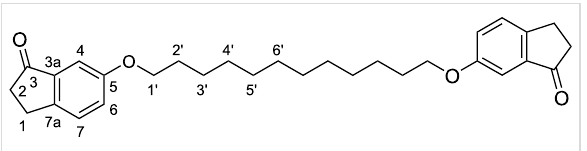
Figure 8: Numbering of carbons in compounds 6a – d , showing 6d as an